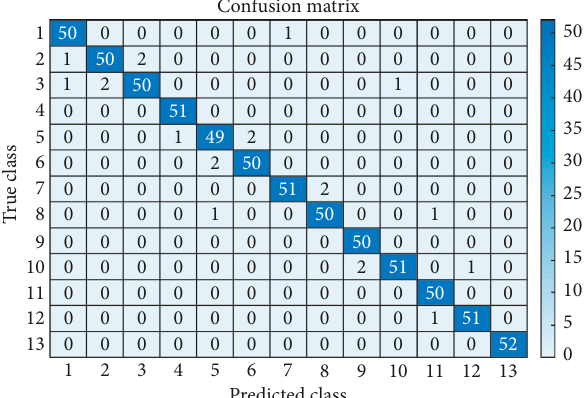
Figure 9: Confusion matrix between all 13 categories of the test set.